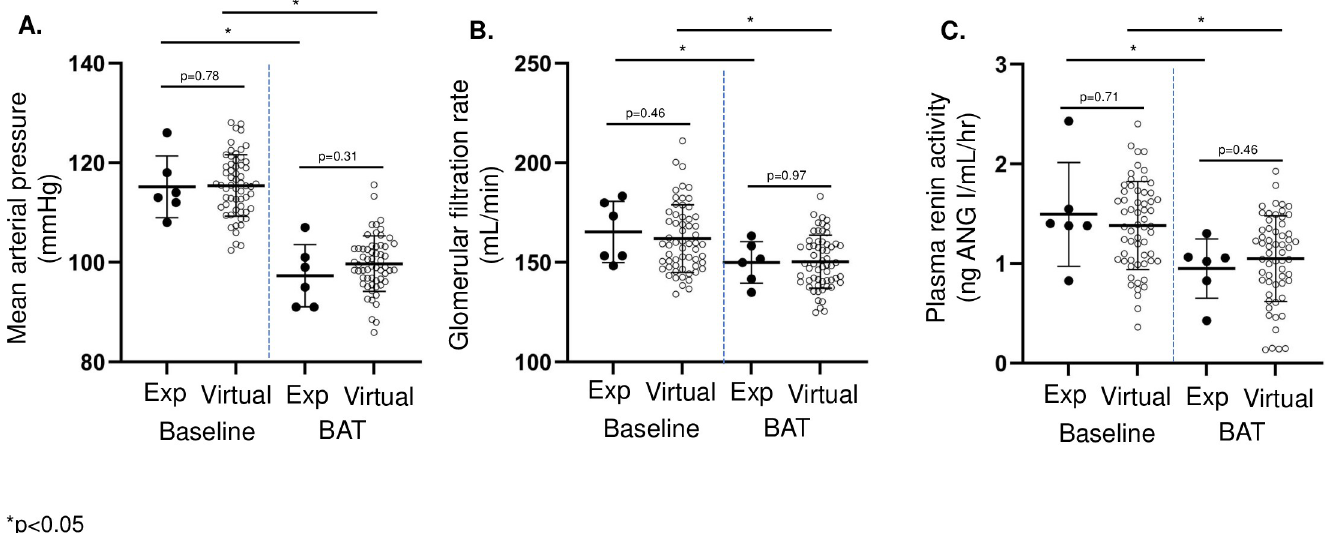
Fig 2. Responses to BAT in experimental [22] (Exp) and virtual populations. Mean arterial pressure, glomerular filtration rate, and plasma renin activity were not significantly different between the two groups at baseline or after BAT.